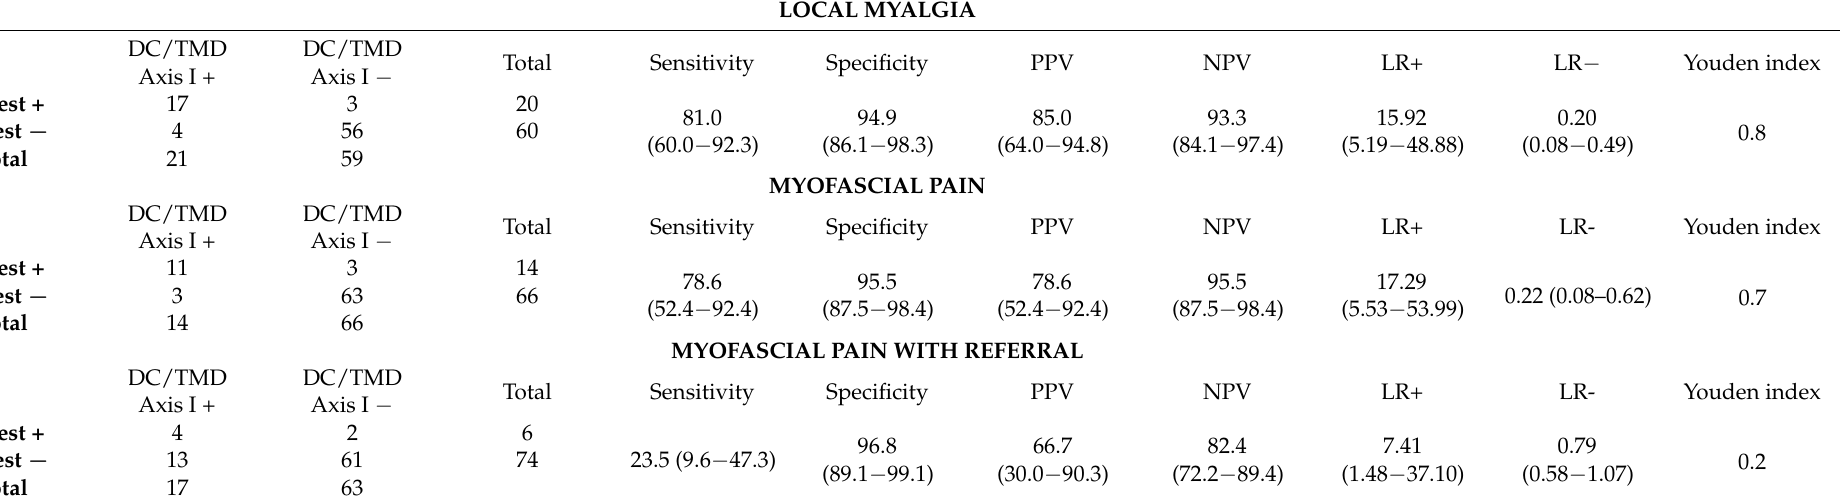
Table 2. Validity results for the ICTest with respect to the types of myalgia according to